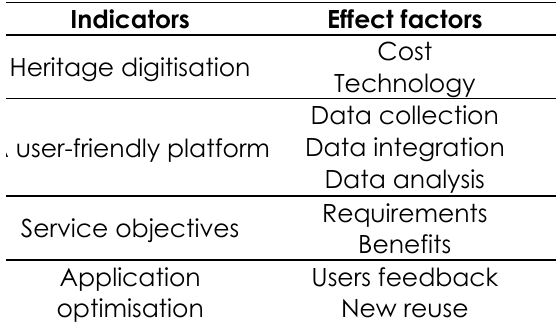
Table 6 . Indicators and Effect